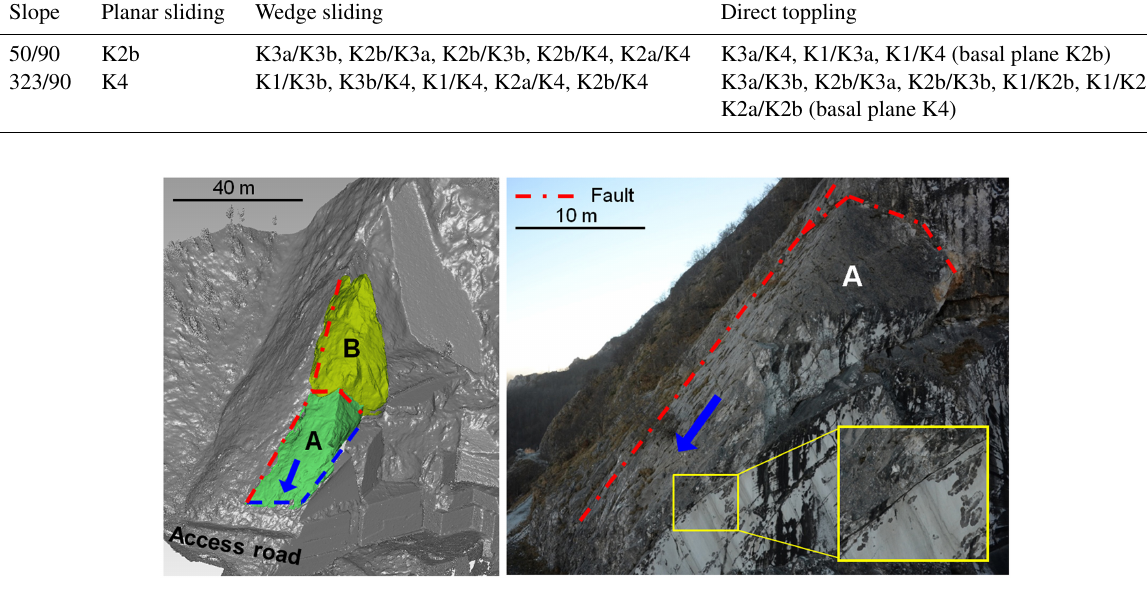
The geometric characteristics of the two blocks, including orientation of the intersecting discontinuities and volume of the meshed block, were obtained using Leica ™ Cyclone 9.0 and are shown in Table